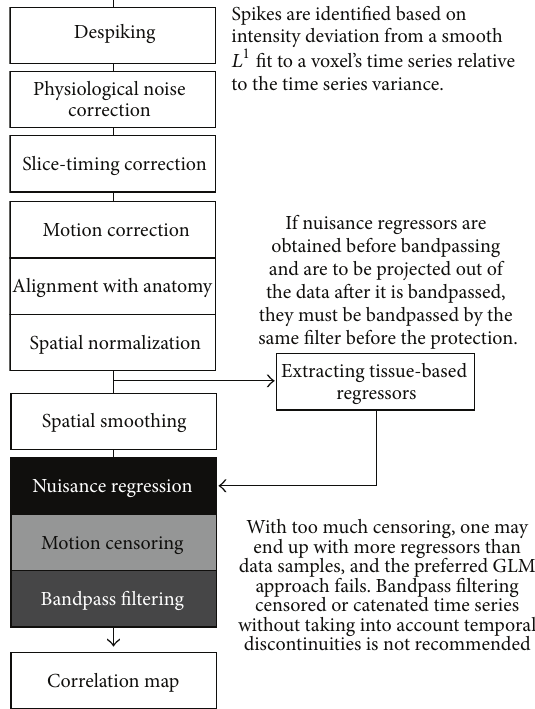
Figure 7: Annotated processing flowchart for RS-FMRI